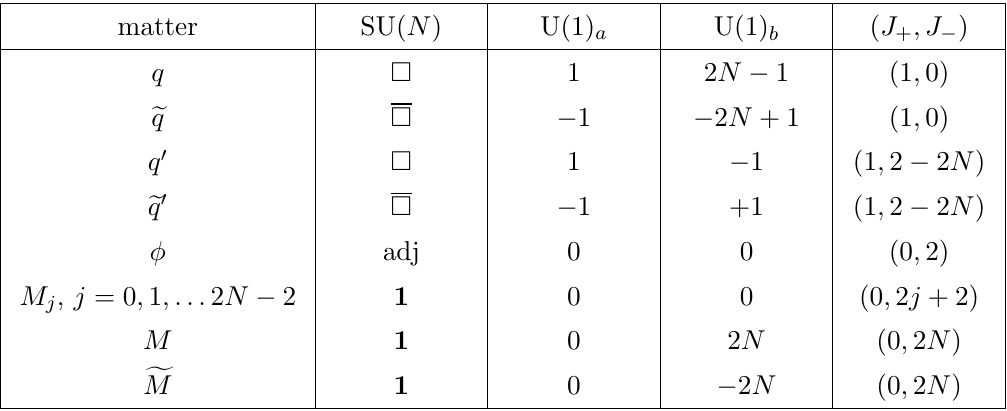
Table 5. The N = 1 matter content for the SU( N ) gauge theory that (cid:13)ows to ( A 1 ; D 2 N ) Argyres- Douglas